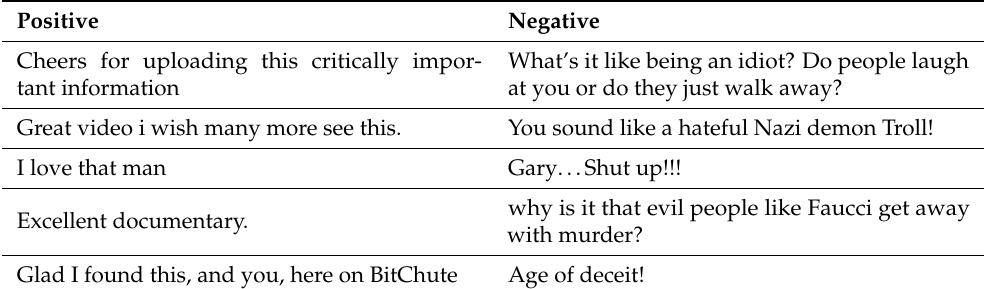
Table 4. Examples of positive and negative comments posted on BitChute videos.